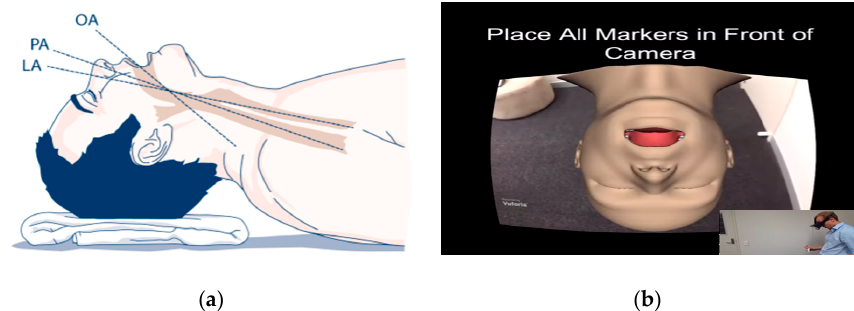
Figure 7. The traditional two-dimensional (2D) ( a ) and mobile 3D simulated ( b ) illustrations of the patient at the end of the triple airways manoeuvre, showing oral ( OA ), pharyngeal ( PA ) and laryngeal ( LA ) axes used for alignment of scope.